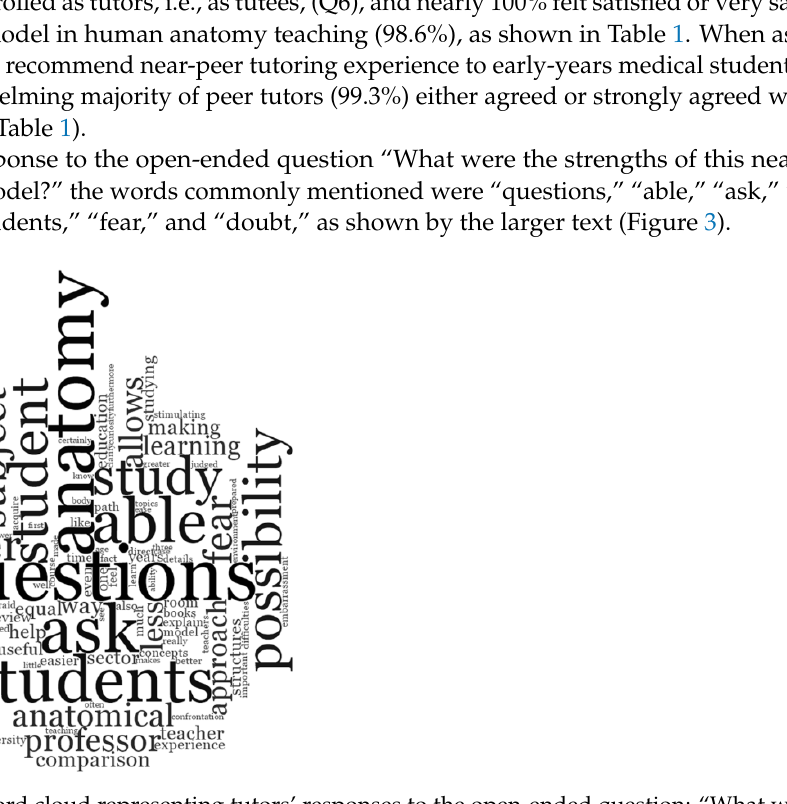
Figure 2. Bar charts showing responses to questions 3, 4, and 5 of the survey. Q3: Attending/graduating at University of Bologna medical school has brought an added value to my